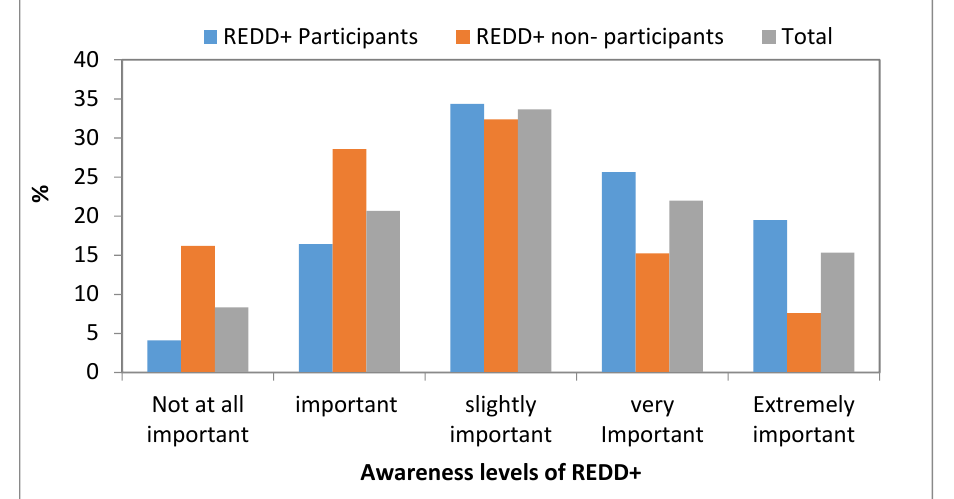
Figure 6. Levels of awareness of REDD+ effects on climate change and the environment of respondents, Con Cuong District, Nghe An Province, 2016.